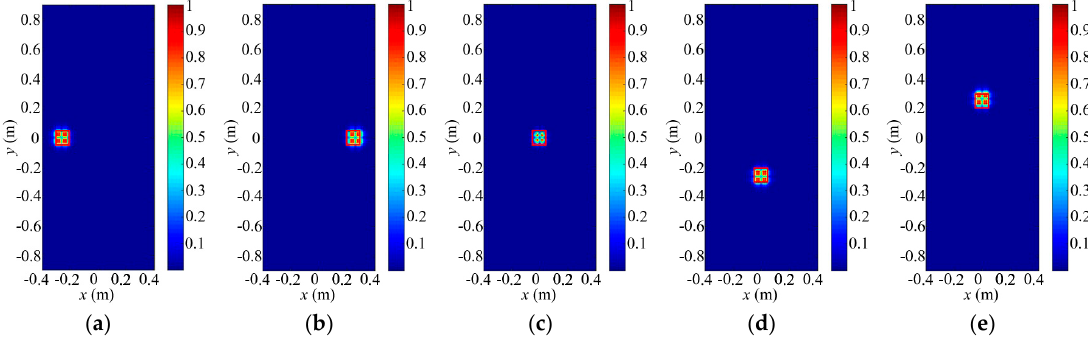
Figure 9. Distributions of incident fields on the right face of the imaging area for different 3D imaging cells with different PPMFs ( f focal @( x 0 , y 0 )): ( a ) 0.2069@( − 0.0603, 0); ( b ) 0.2069@(0.0603, 0); ( c ) 0.2046@(0, 0); ( d ) 0.2069@(0, − 0.0603); and ( e ) 0.2069@(0, 0.0603).